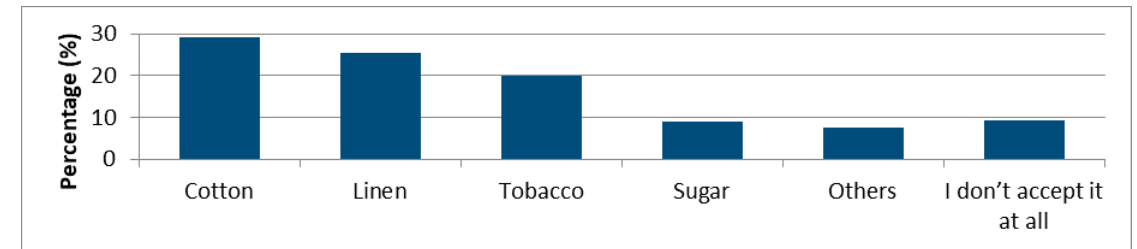
Figure 9. Preferences for edible crops applications.